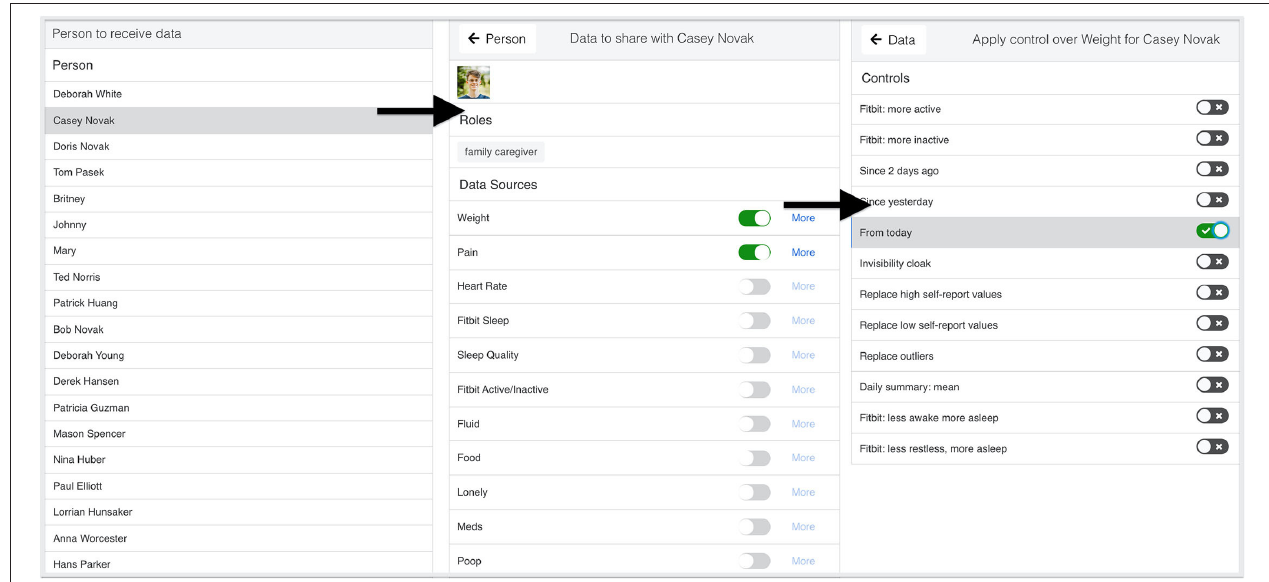
FIGURE 7 | An adapted version of the layered design by Bahirat et al. (2018): each layer provides options to fine-tune data sharing, starting with the person, data, and then control. Users who want to fine-tune the details being shared can find different options in subsequent layers (Profile photo by Carlos Lindner on Unsplash).